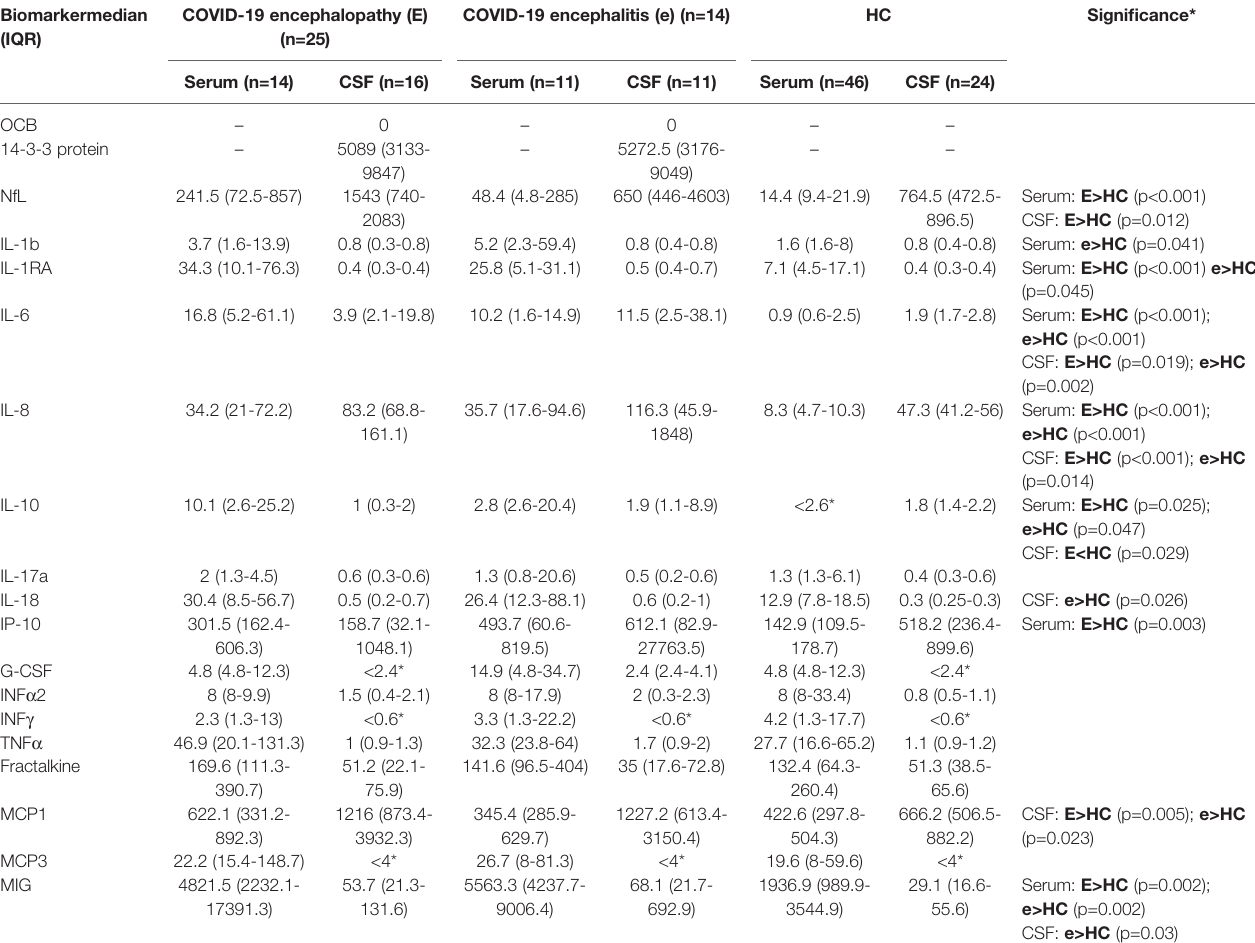
TABLE 2 | Serum and CSF biomarkers of in fl ammation and neuronal damage in 36 patients with COVID-19 associated encephalopathy and encephalitis. Biomarkermedian COVID-19 encephalopathy (E) (IQR)